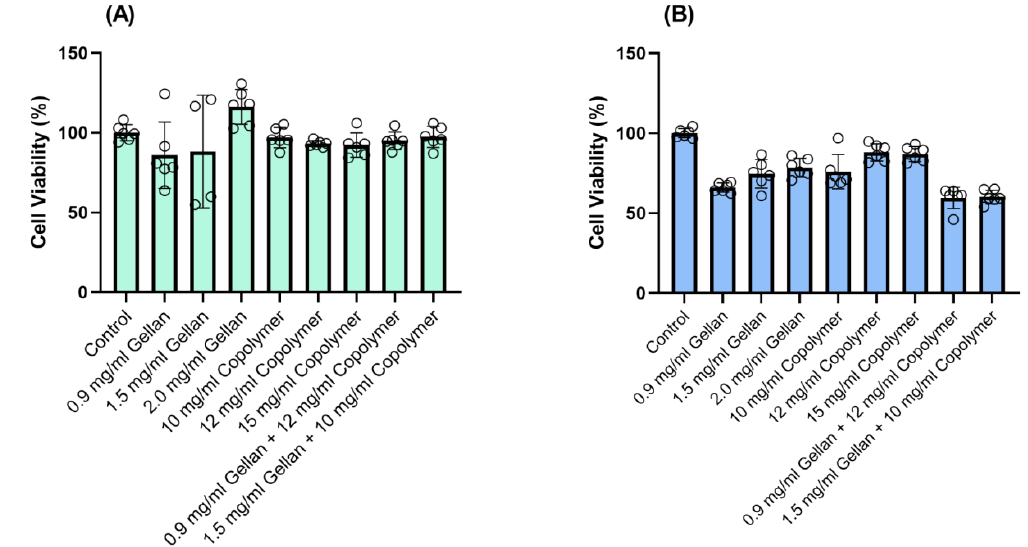
Figure 4. The viability of confluent ( A ) ppRPE, and ( B ) 3T3 / NIH cells after exposure to thiolated gellan, poly(MAM-co-MAA-co-BMAC), and the combined components for 72 h. Values are given in mean ± SEM (n = 6).